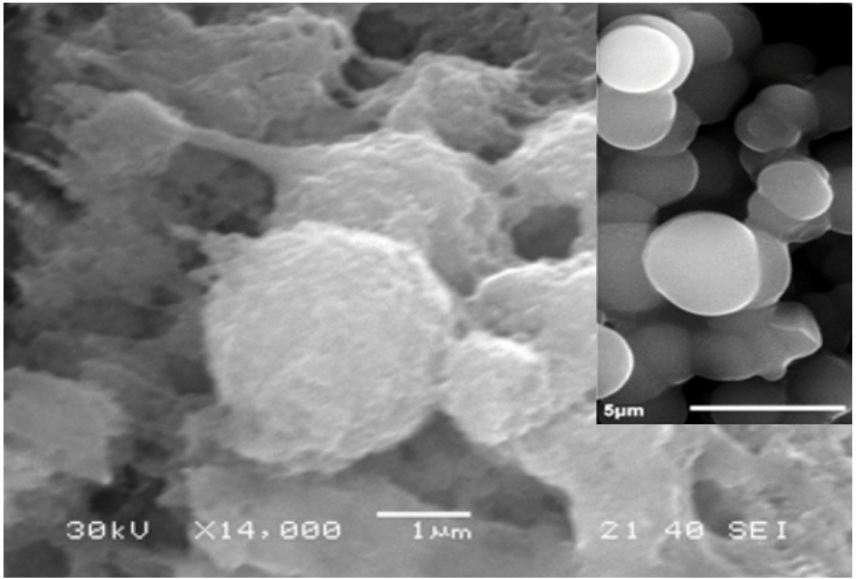
Figure 2. SEM results of bacteria Paracoccus yeei VKM B-3302 encapsulated in a sol–gel matrix (the inset shows a micrograph of free